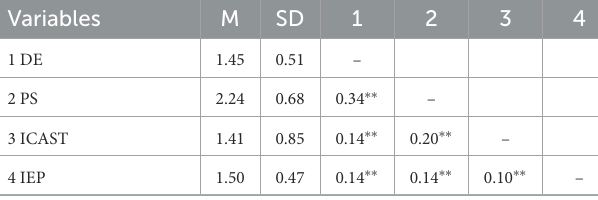
TABLE 1 Means, standard deviations, and correlations between study variables ( n = 855).